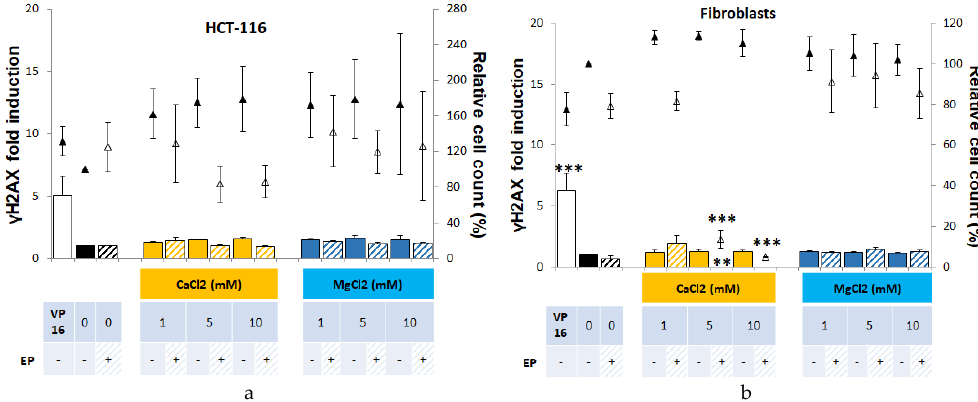
Whether in tumor HCT-116 cells or in normal dermal fibroblasts, neither calcium nor magnesium (1, 5, or 10 mM) associated with electroporation induced genotoxicity (Figure 3). When associated with electroporation, 5 and 10 mM calcium induced a statistical significantly reduced cell viability, respectively to 83% and 86% viability in HCT-116, and 13% and 5% viability in dermal fibroblasts. Interestingly, while CaCl 2 and MgCl 2 solutions present the same osmolarity, no significant toxic effect of magnesium was observed when associated with electroporation.